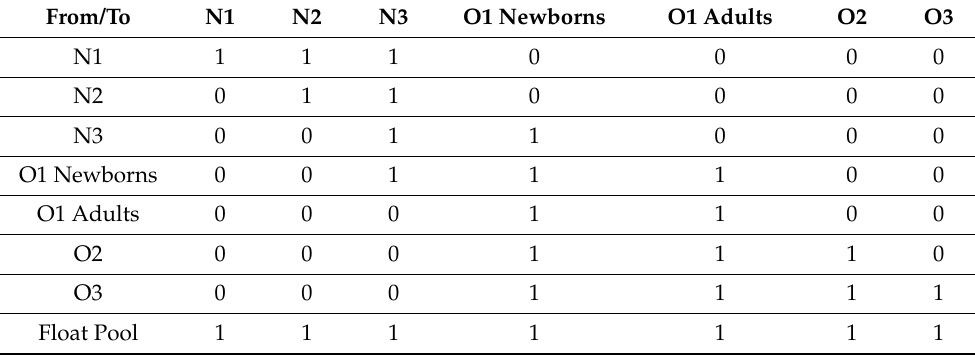
Table 7. Nurse matrix for Models 2 and 3 for the Perinatology Care System. From/To